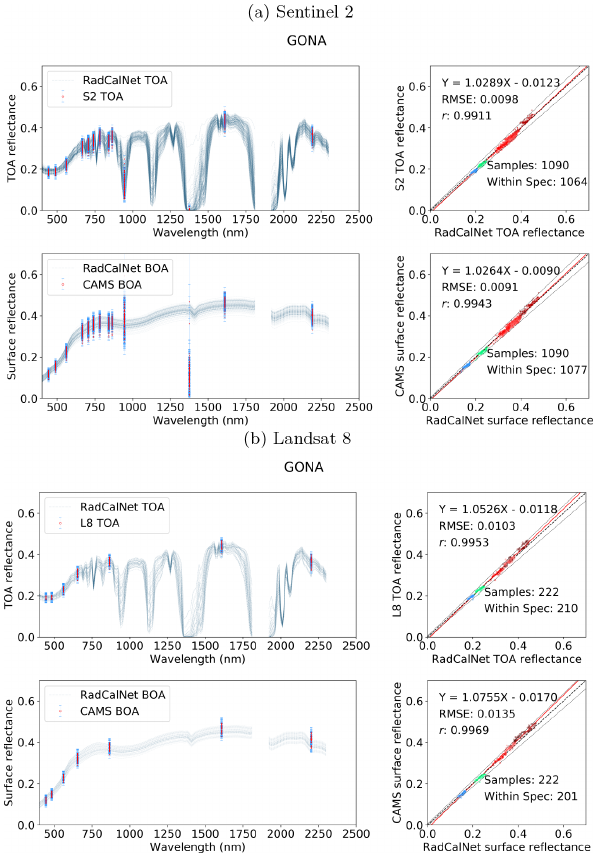
Figure I1. Comparison between the S2 (a) and L8 (b) TOA re- flectance and RadCalNet simulated nadir-view TOA reflectance (top row), and the surface reflectance after correction with CAMS prior against RadCalNet nadir-view surface reflectance (bottom row) at Gobabeb. The blue lines on the left are different spectra measurements from RadCalNet, and the red dots with blue error bars (1 standard deviation) are the TOA or surface and TOA re- flectance with uncertainty. The threshold uncertainty is given as black dashed lines in the scatter plots. The regression line is drawn as a red line, and the 1-to-1 reference line is drawn as a thick black dashed line in the